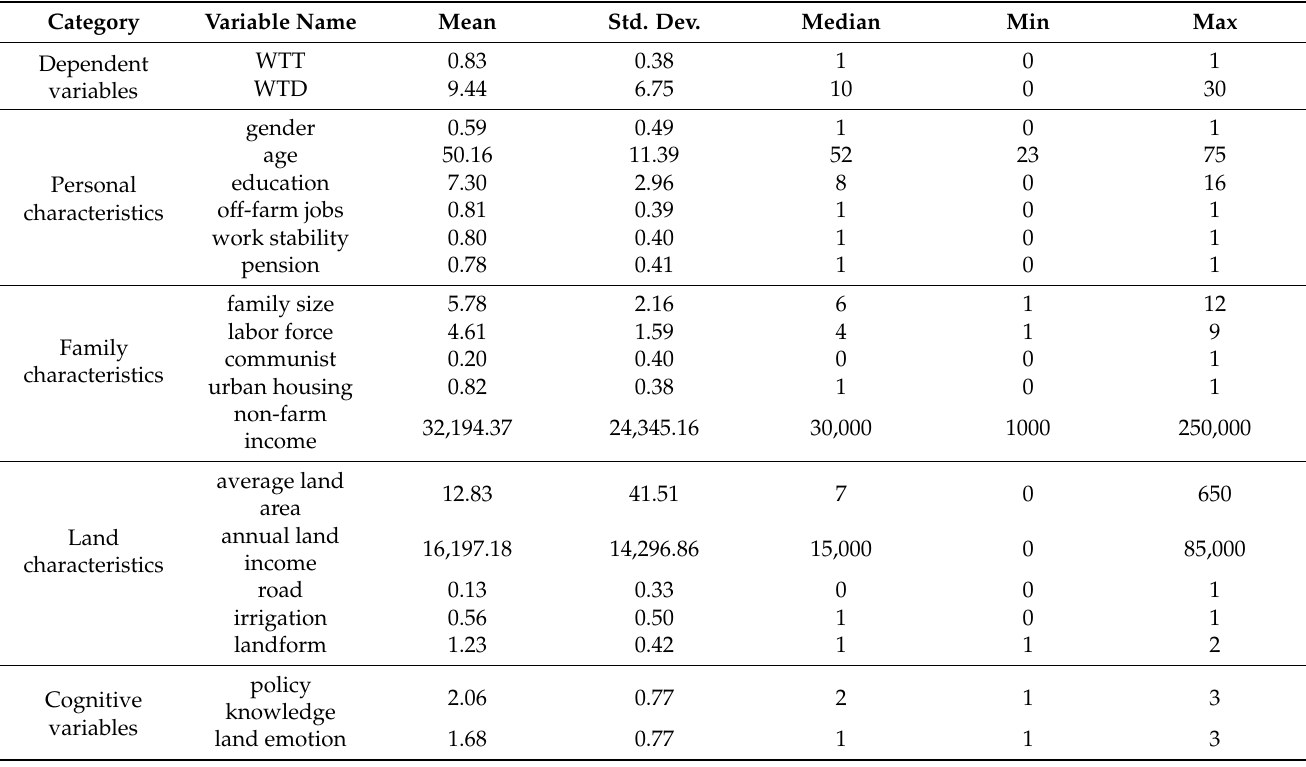
Table 3. Descriptive